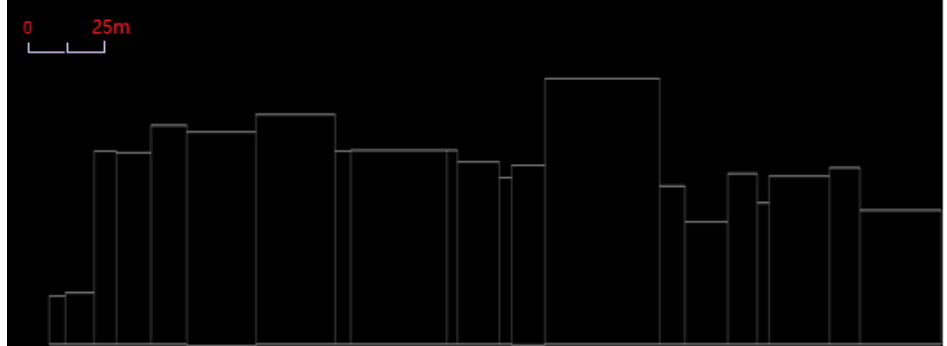
Figure 12. Result of sub-polygon simplification.